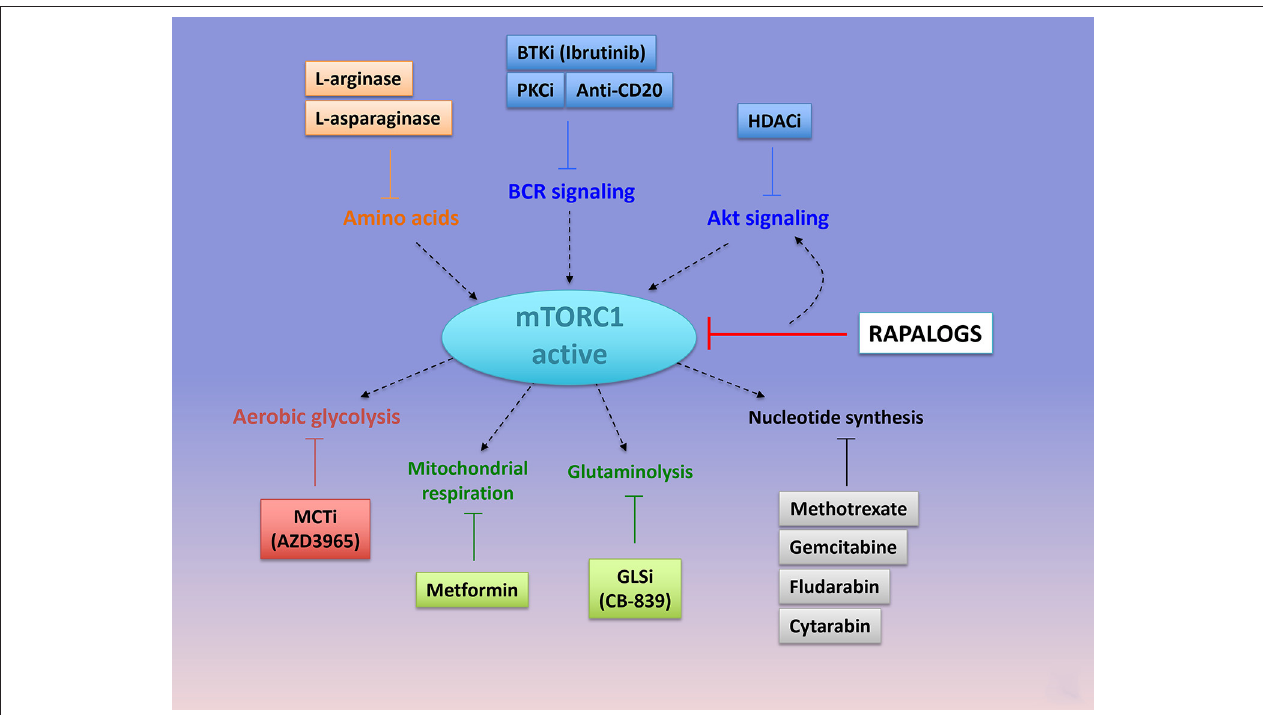
FIGURE 5 | Emerging combinations with Rapalogs. Rapalogs only partially inhibit mTORC1 signaling. Already available drugs (approved or under clinical evaluation) can be combined with rapalogs in order to induce tumor cell killing. By inhibited S6K phosphorylation, rapalogs prevent the negative feedback loop on PI3K/Akt, resulting in PI3K/Akt activation. mTORC1 can be targeted with upstream kinases involved in BCR signaling (with anti-CD20 antibody or the PKC inhibitor AEB071, or the BTK inhibitor Ibrutinib) or in Akt signaling (with HDAC inhibitors, panobinostat or vorostinat). Hydrolysis of amino acids that are required for mTORC1 activation, such as arginine (with L-arginase), or glutamine (L-asparaginase), can further abolish mTORC1 signaling and induce cell death when combined with rapalogs. mTORC1-dependent regulation of metabolism is essential to induce an anabolic program promoting cell growth. Combined Rapalogs with inhibitor of glycolysis (MCT1 inhibitor, AZD3965), or mitochondrial complex I activity (Metformin) or gutaminolysis (GLS inhibitor, CB-839) or nucleotide synthesis (Methotrexate or Gemcitabine or Fludarabine or cytarabin), might improve patient’s response. Importantly, the choice of the anti-metabolic strategy depends on the metabolic status of the tumor cells. PKC, Protein Kinase C; BTK, Bruton’s Tyrosine Kinase; HDAC, histone deacetylase; MCT, Monocarboxylate